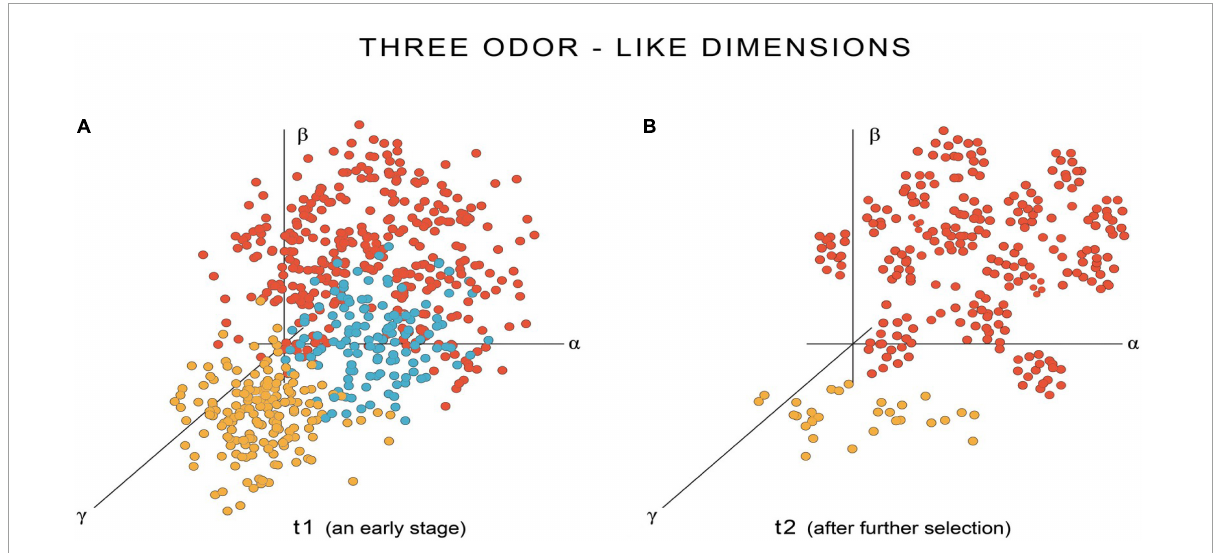
FIGURE4 As in Figure 3 , but a second set of point clouds in three other E-space dimensions ( α , β , and γ ) that map odor- rather than light-like properties. Blue, orange and red point clouds represent the odor-like components of ur-qualia for light, sound, and odor, respectively, as before. In (A) again an early stage in the evolutionary process of refinement, there is overlap between the three modalities, so that experience of both light (blue) and sound (orange) will have some odor-like properties. In (B) a later stage, the point cloud for odor has evolved into a clustered array, whereas odor-like features of light experience have been eliminated, and for acoustic experience, nearly so. The result overall is that the properties of qualia are sorted so as to optimize the way each is experienced while, at the same time, eliminating overlap between different categories of experience. The clustering of the olfactory point cloud in (B) unlike the disc used for light in the previous figure, is meant to indicate that, for olfaction, arranging for the sensations associated with related olfactory experience to be clustered, and perhaps to extend to many more dimensions, might be a way to enhance the ability to store and recall related odor experiences from memory in a systematic way. The point is made simply as a reminder that the shape and dimensionality of point clouds in E-space will likely differ, perhaps dramatically so, between different sensory